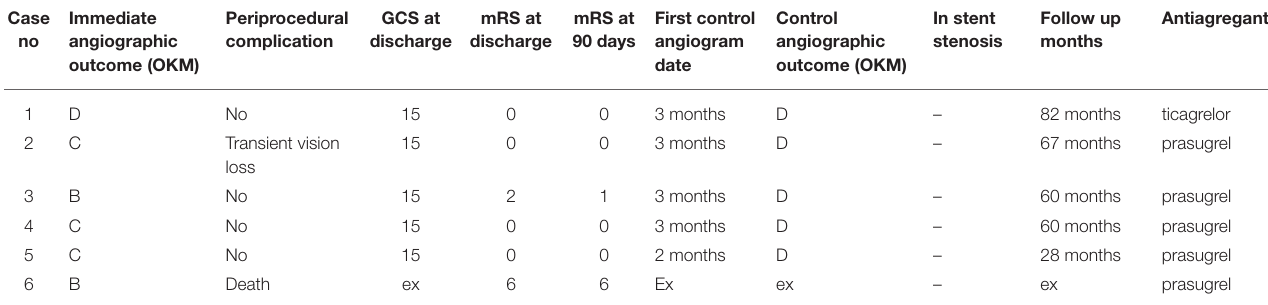
TABLE 2 | Clinical and radiological outcomes, follow-up measures and antiplatelet regimen.